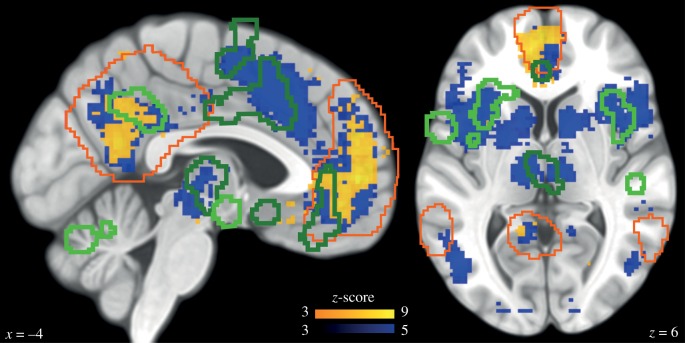
Overlap between DN, self and autonomic regulation meta-analyses. The orange outline represents the DN, as defined in Laird [35]. Green outlines highlight regions responsible for sympathetic (dark green) and parasympathetic (light green) regulation [34]. The results of the automated [31] meta-analysis on the term ‘self’ are presented in yellow (reverse inference map) and in blue (forward inference map). The sagittal view (left) shows that the reverse inference map of the self is associated with the DN, where it overlaps with autonomic regulation regions. The axial view (right) shows that the rAI is associated with the forward inference map of the self and overlaps with autonomic regulation regions.